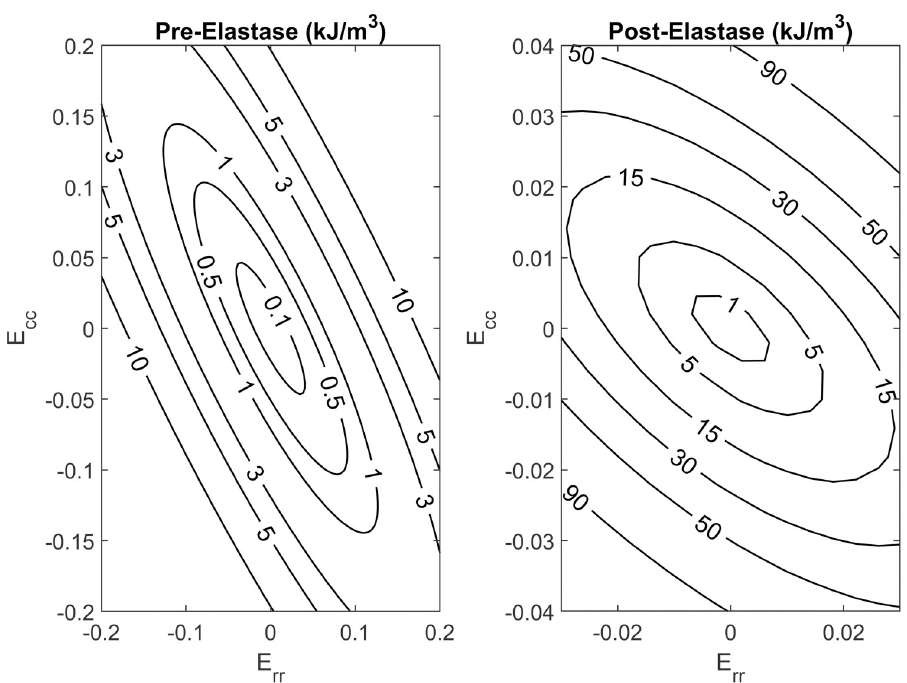
Fig 6. Strain energy density contours, generated before and after elastin digestion, for a typical heart in the elastase treated group.